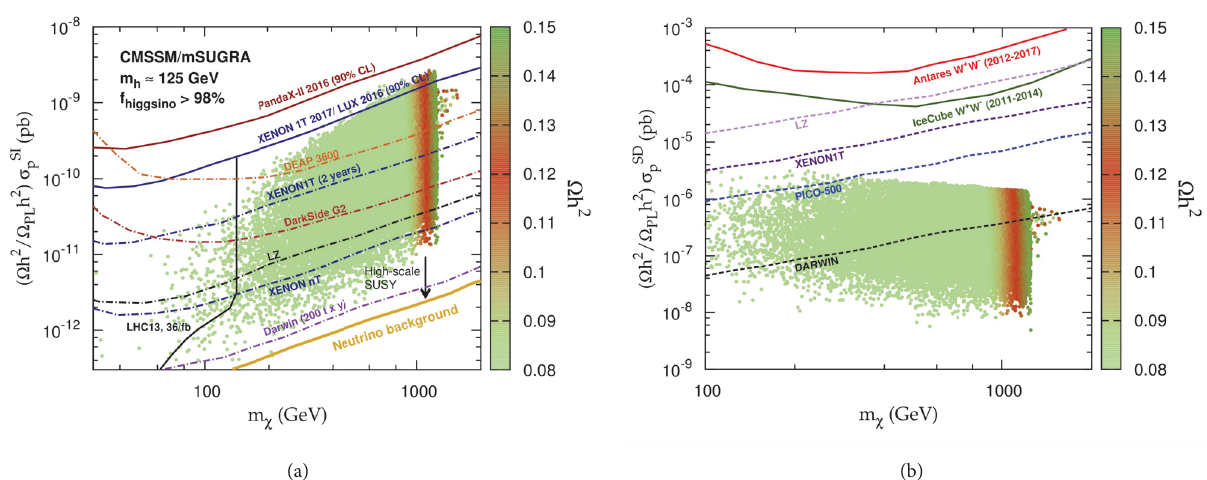
Figure 4: (a) Spin-independent neutralino-nucleon cross section 𝜎 SI 푝 rescaled by the relic abundance, as a function of neutralino mass 𝑚 휒 , for a nearly pure higgsino with CMSSM/mSUGRA boundary conditions subject to 𝑚 ℎ ≈ 125 GeV and LHC Higgs bounds. Solid lines show the 90% CL upper bounds from PandaX-II [74] (maroon) and XENON1T [75] (LUX [76]) (blue). Dot-dashed lines show the projected reach for DEAP-3600 [77] (orange), XENON1T/nT [78] (blue), DarkSide G2 [79] (maroon), LZ [80] (black), DARWIN (purple) [81]. Thin solid black line shows the current lower bound on mass from direct searches at the LHC [82, 83]. (b) Rescaled spin-dependent neutralino nucleon cross section 𝜎 SD 푝 as a function of neutralino mass 𝑚 휒 , for the a nearly pure higgsino in the CMSSM/mSUGRA. Solid lines show the 90% CL indirect upper bounds from IceCube [84] (green) and Antares [85] (red). Dashed lines show projections for LZ [86] (violet), XENON1T [78] (purple), Pico-500 [87] (blue), and DARWIN [81] (black).